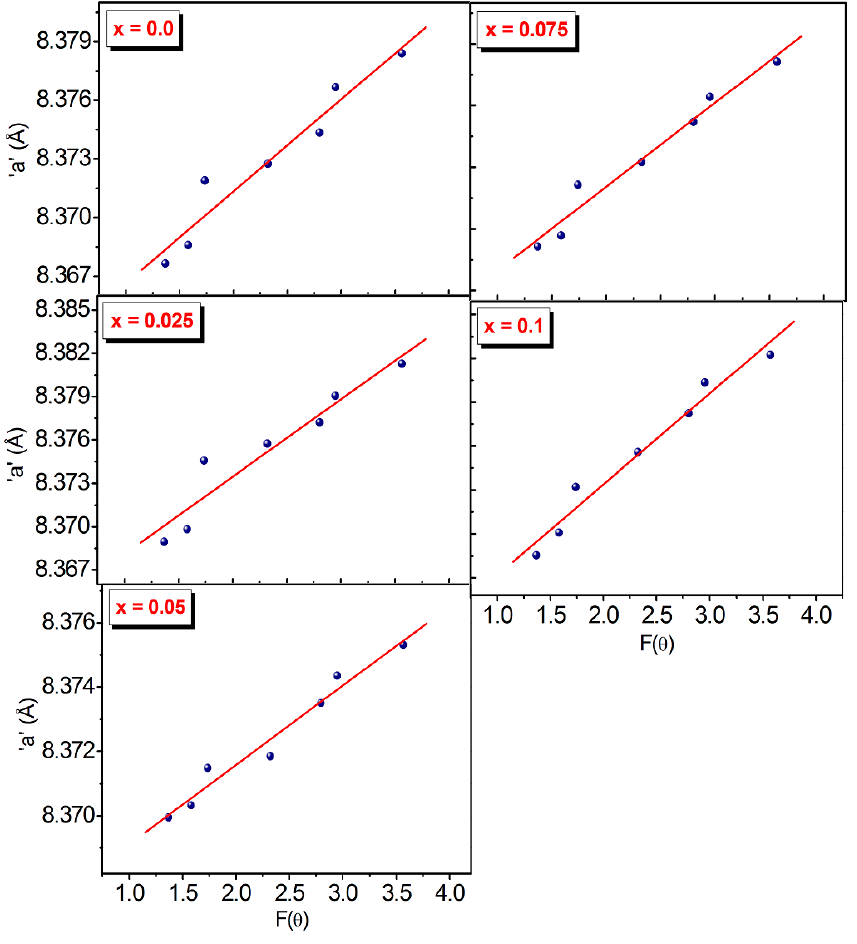
Figure 2. Plots of NR function for CoCr 0.5 Dy x Fe 1.5 − x O 4 . Table 1. Rietveld Re fi ned parameters of CoCr 0.5 Dy x Fe 1.5-x O 4. Table 2. Lattice parameter obtained from N-R function ( a 0 ), X-ray density ( ρ x-ray ), bulk density ( ρ exp ), porosity ( P ), specific surface area ( S ), average crystallite size ( t xrd ), lattice strain ( ε ) for the